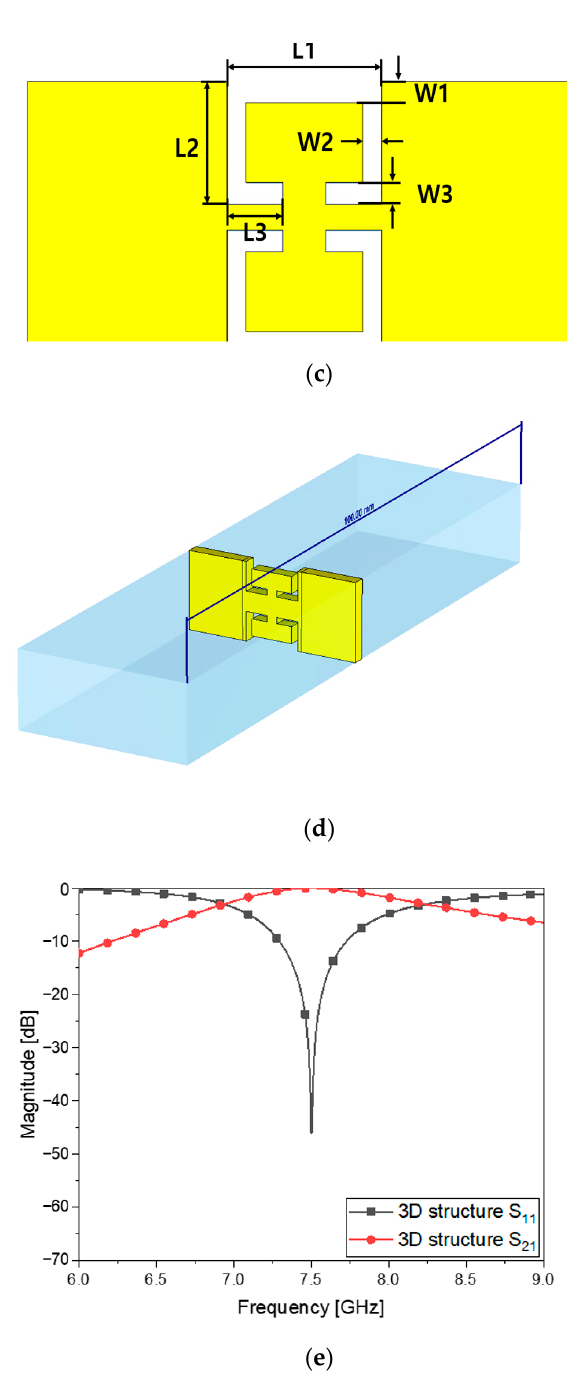
Figure 3. Circuit model of the CRLH resonator and moved into the waveguide. ( a ) E-CRLH circuit of the resonator applied to the waveguide cross section; ( b ) S 11 and S 21 of the resonator circuit; ( c ) physical shape of the thin resonator; ( d ) the resonator is longitudinally flat; ( e ) S 11 and S 21 of the resonator structure.